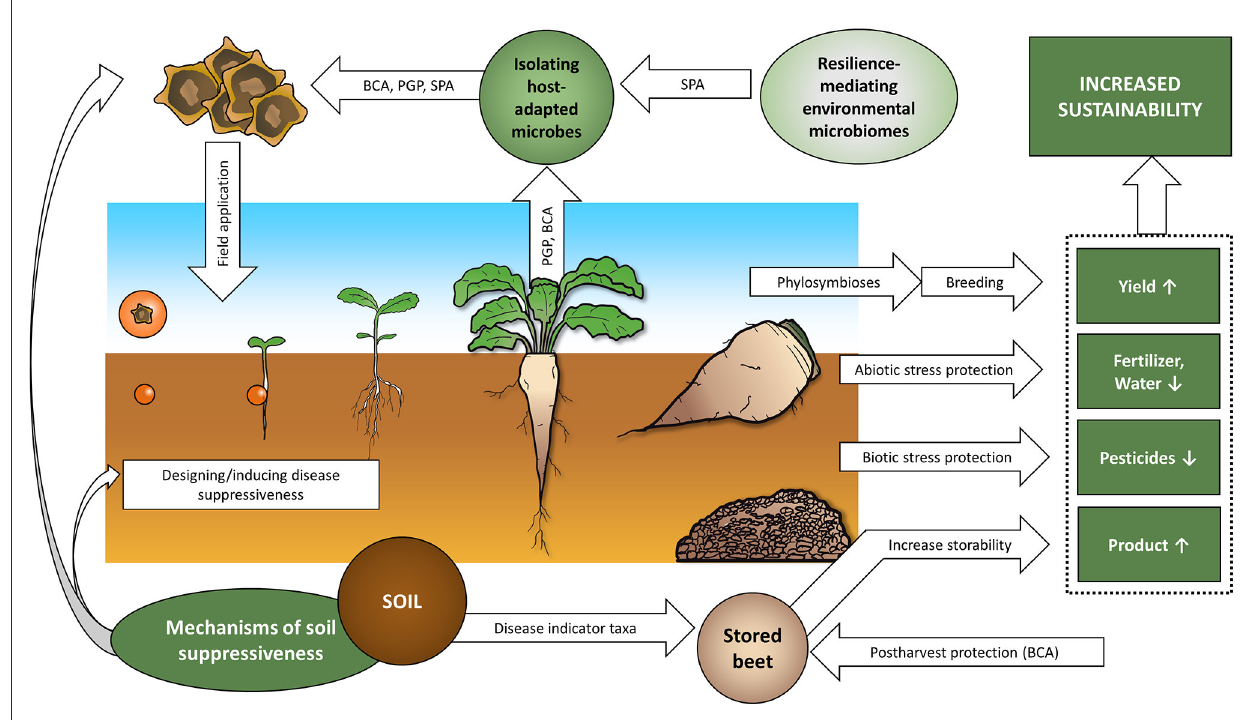
FIGURE3 Summary of microbiome-based targets to increase sugar beet farming sustainability. BCA, Biological control agents; PGP, plant growth promoter; SPA, stress protecting agents. For a description see Section